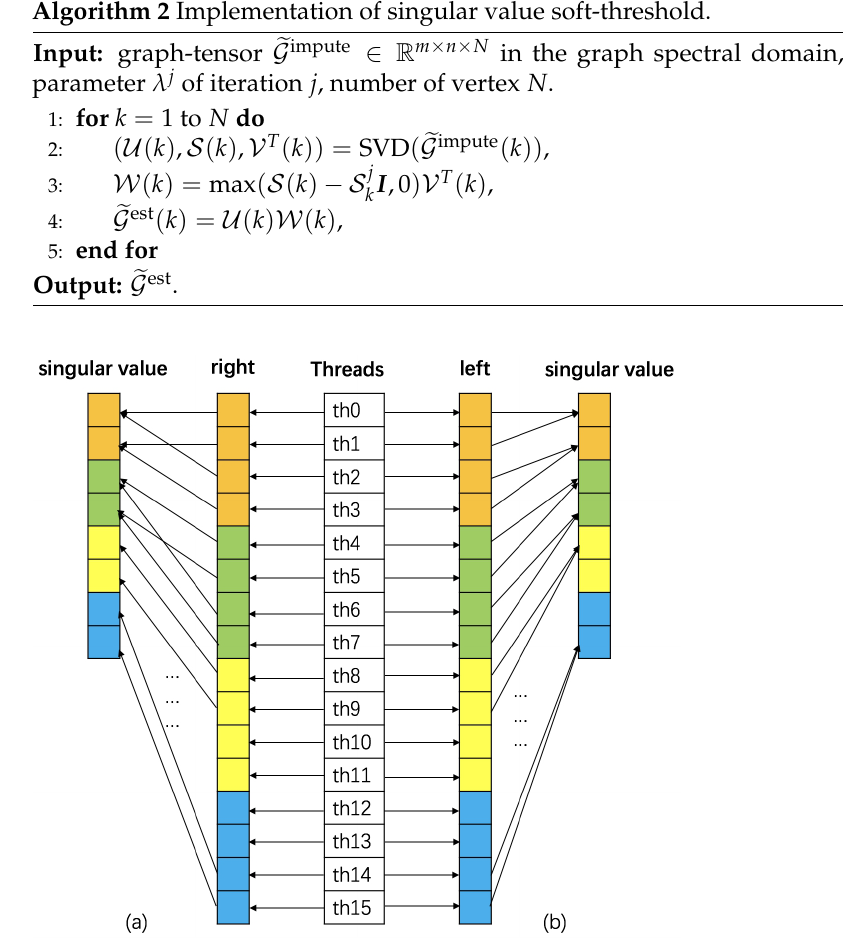
Figure 4. Thread mapping to perform the diagonal matrix-matrix multiplication of a batch of matrices. The diagonal matrix in ( a ) is to the left of the operator, which enables coalesced memory access to device memory, and in ( b ) is to the right of the